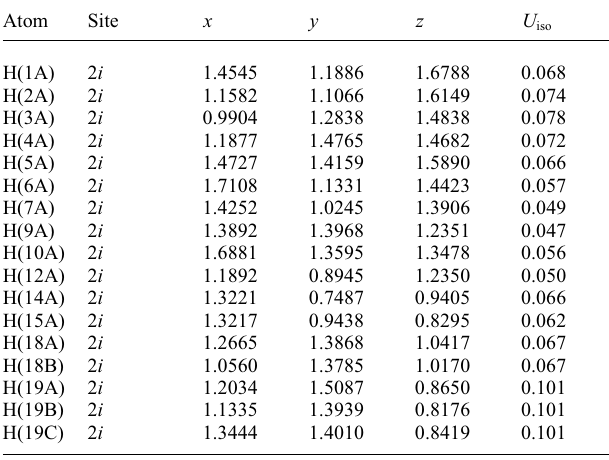
Table 1. Data collection and handling. Table 2. Atomic coordinates and displacement parameters (in Å 2 )